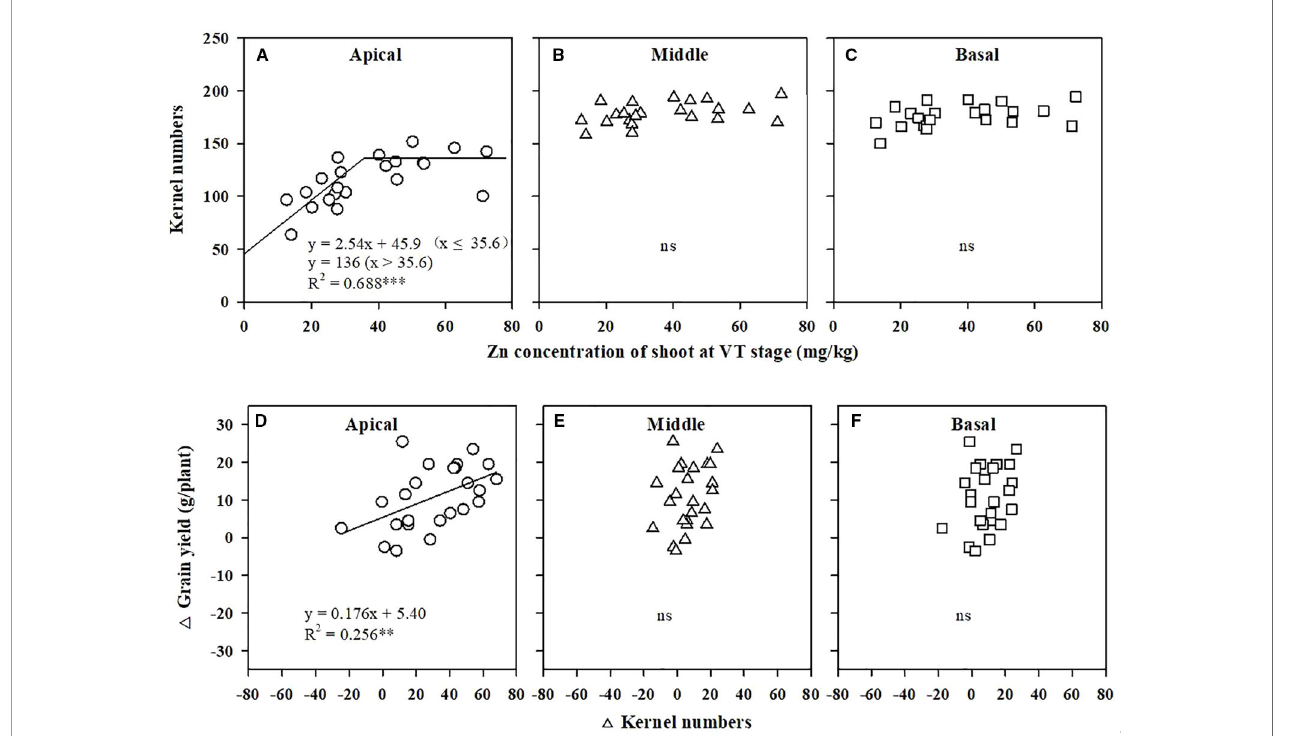
FIGURE 3 | Correlations of kernel numbers in the apical (A) , middle (B) , and basal (C) sections of maize spikes with the Zn concentration in shoots at the tasseling (VT) stage. Correlations of the change in grain yield with the change in kernel numbers of the apical (D) , middle (E) , and basal (F) sections of maize spikes. *** P < 0.001, ** P < 0.01. ns, not signi fi